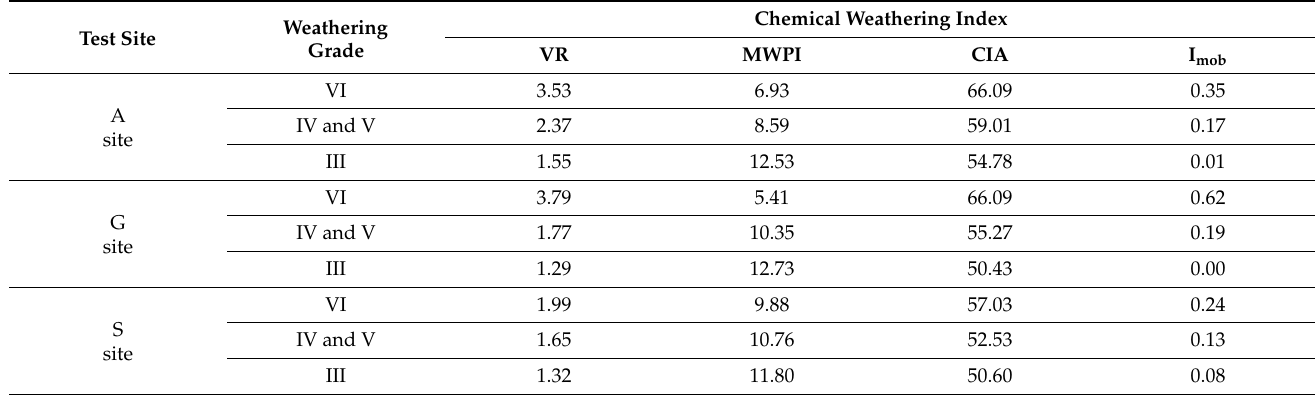
Table 4. Average chemical weathering